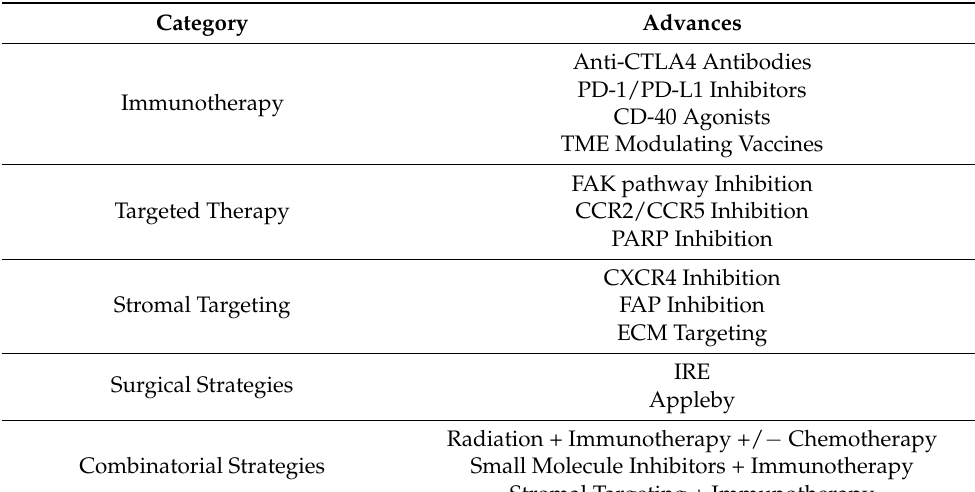
Table 1. Summary of Advances in PDAC Treatment